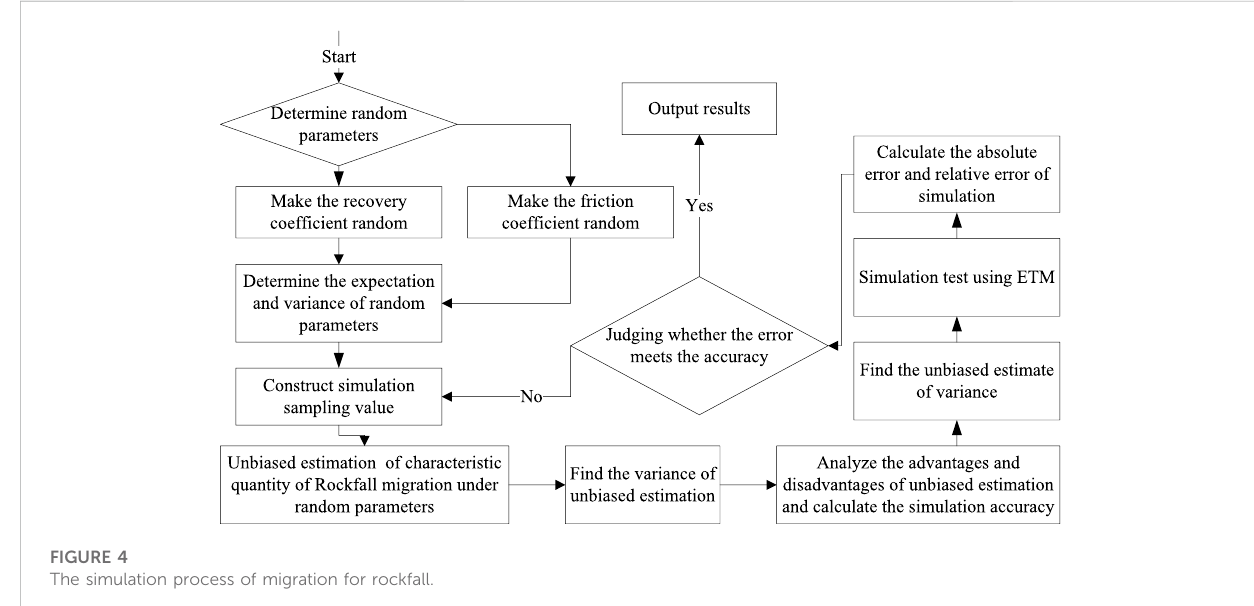
FIGURE 4 The simulation process of migration for rockfall.